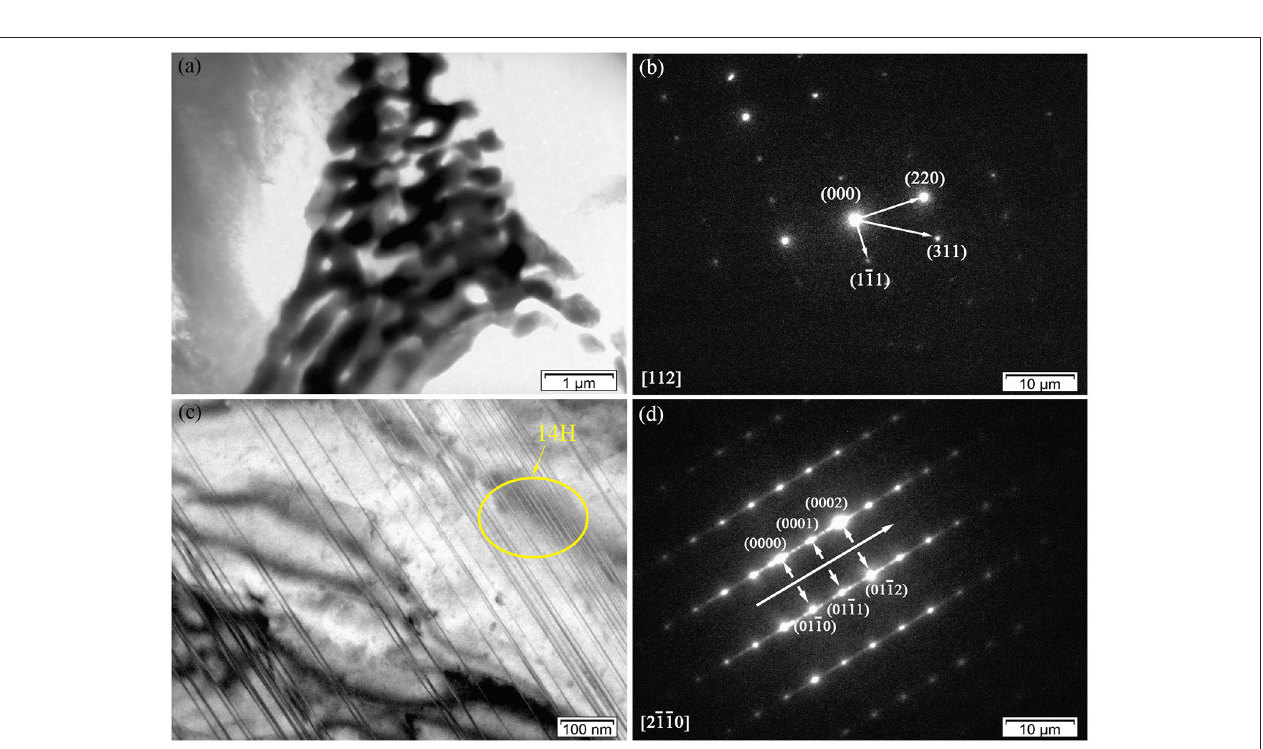
FIGURE 4 | Microstructure of the as-cast Mg-2.0Zn-0.5Zr-3.0Gd alloy: (a) BF TEM image of continuous network eutectic phase; (b) SAED pattern corresponding to the eutectic phase; (c) BF TEM image of the LPSO phase distributed inside the grains; (d) SAED pattern corresponding to the LPSO phase.